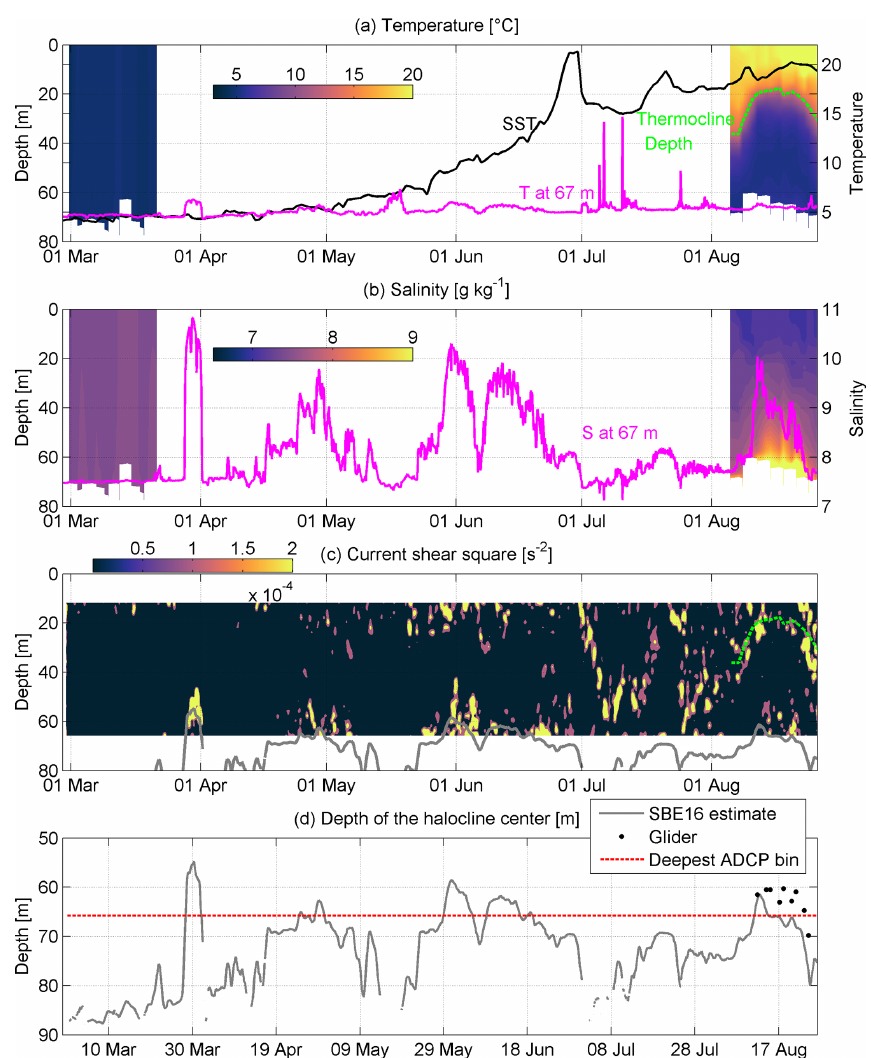
Figure 6. Temporal courses of temperature, salinity, current shear squared, and halocline depth at the ADCP location from March to Septem- ber 2020 (see Fig. 1b and c). (a) Temporal course of sea surface temperature (SST) and temperature at 67m depth; temporal course of the vertical distribution of mean temperature in March and August calculated from glider data (color scale). The depth of the thermocline center is shown as a red dashed line. (b) Temporal course of salinity at 67m depth; temporal course of the vertical distribution of mean salinity in March and August calculated from glider data (color scale). Mean temperature and salinity profiles were calculated for each glider passing within the 3.7km zonal window around the ADCP location. The depth of the thermocline center is shown as a red dashed line. (c) Tem- poral course of the vertical distribution of current shear squared and depth of the halocline center (grey line). (d) Depth of halocline center calculated from SBE16 data and in August from glider data. The depth of the deepest ADCP bin is also shown (red dotted line).